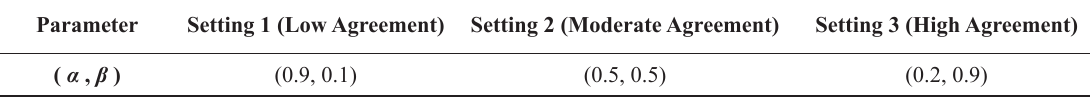
Table 1: Initial values of two parameters for different settings in simulation. Parameter Setting 1 (Low Agreement) Setting 2 (Moderate Agreement) Setting 3 (High